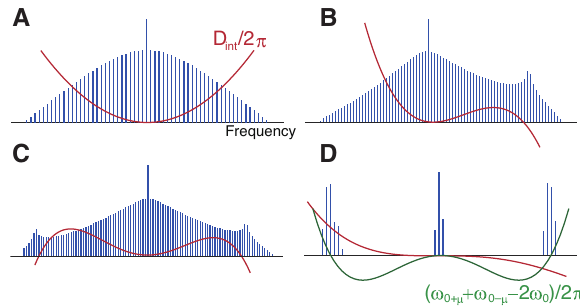
Figure 12: Spectra of Kerr frequency comb and corresponding dispersion D (solid red int